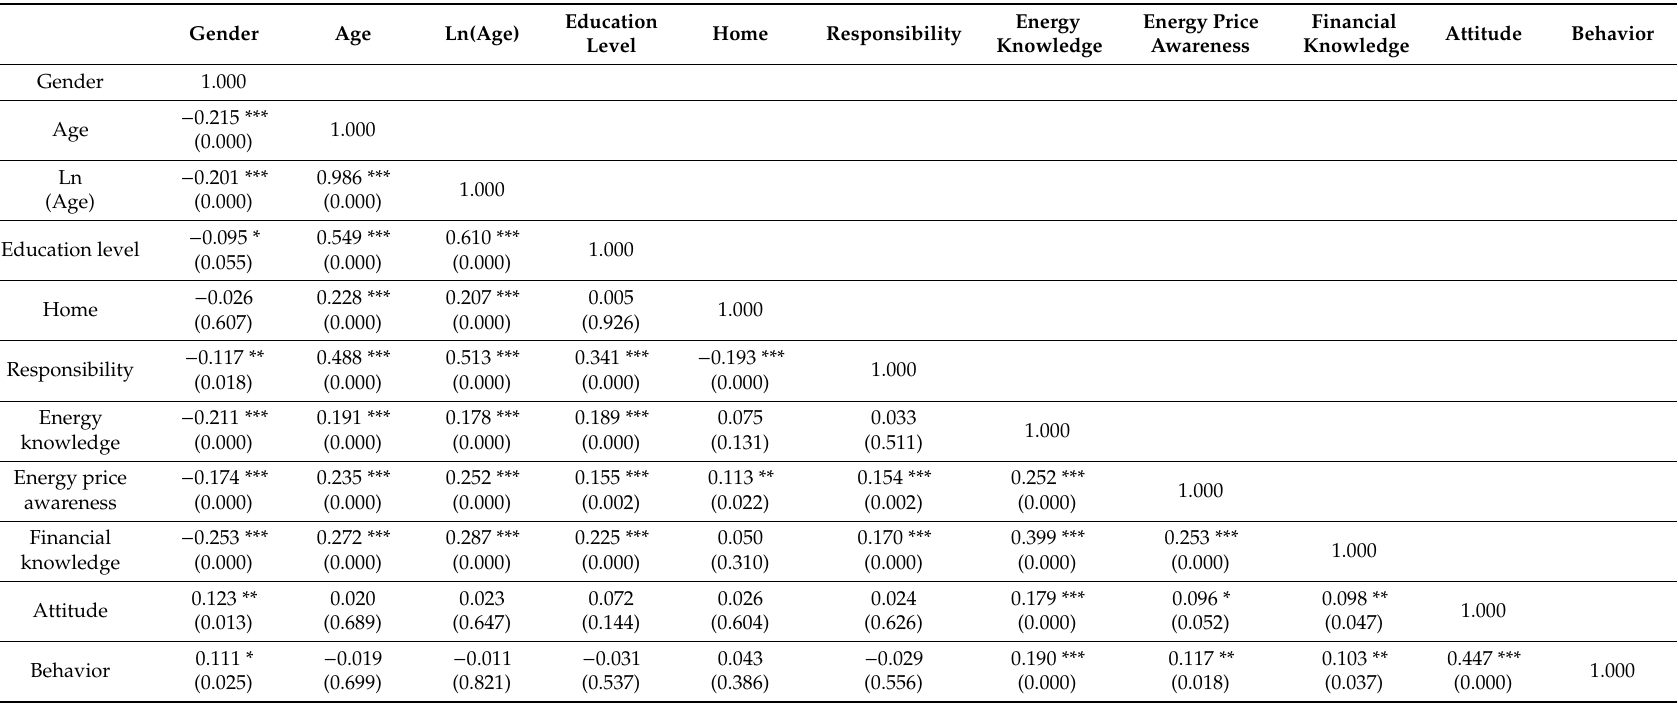
Table 1. Correlations between